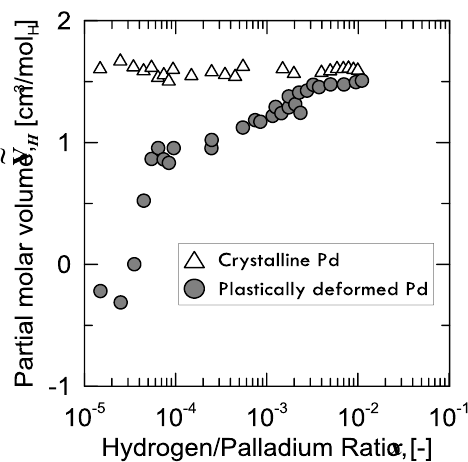
Figure 6. Partial molar volume of hydrogen measured in crystalline Pd (open triangles) and in plastically deformed Pd (closed circles) by cold drawing and rolling, as a function of hydrogen concentration in palladium (number of H-atoms per number of Pd-atoms). Adapted from Kirchheim [28].